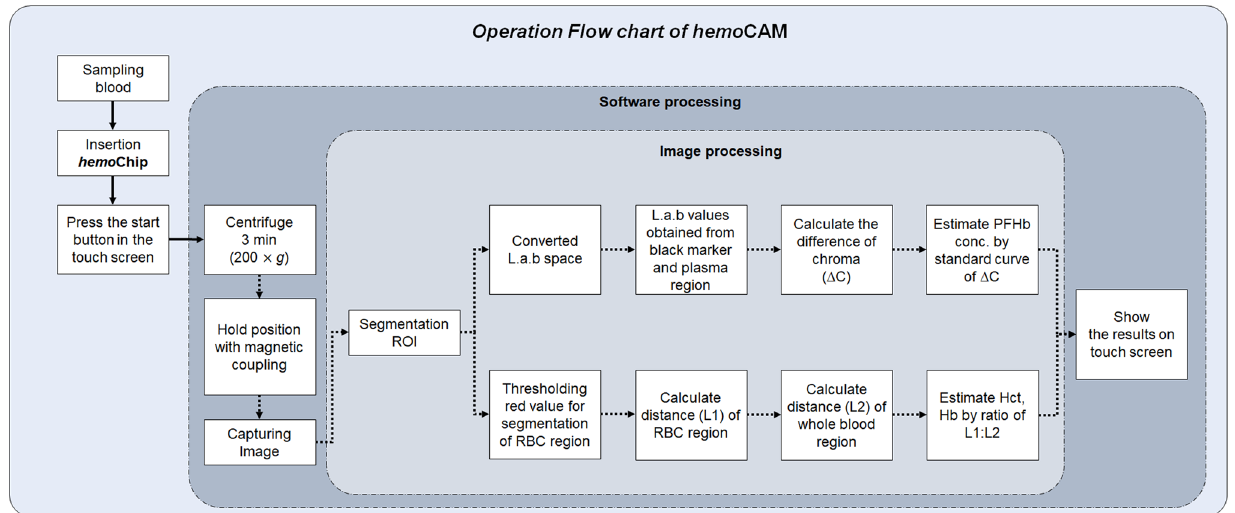
Figure 2. Operation flow chart. After inserting the cartridge, the custom software program starts the centrifugation. At the end of centrifugation, the cartridge holder is stopped by magnetic coupling with the housing at the specified location for image capture. Image analysis is performed simultaneously with the color space analysis of PFHb, Hct, and Hb. The analyzed result is printed on the touchscreen, and all of this process is completed within only 4